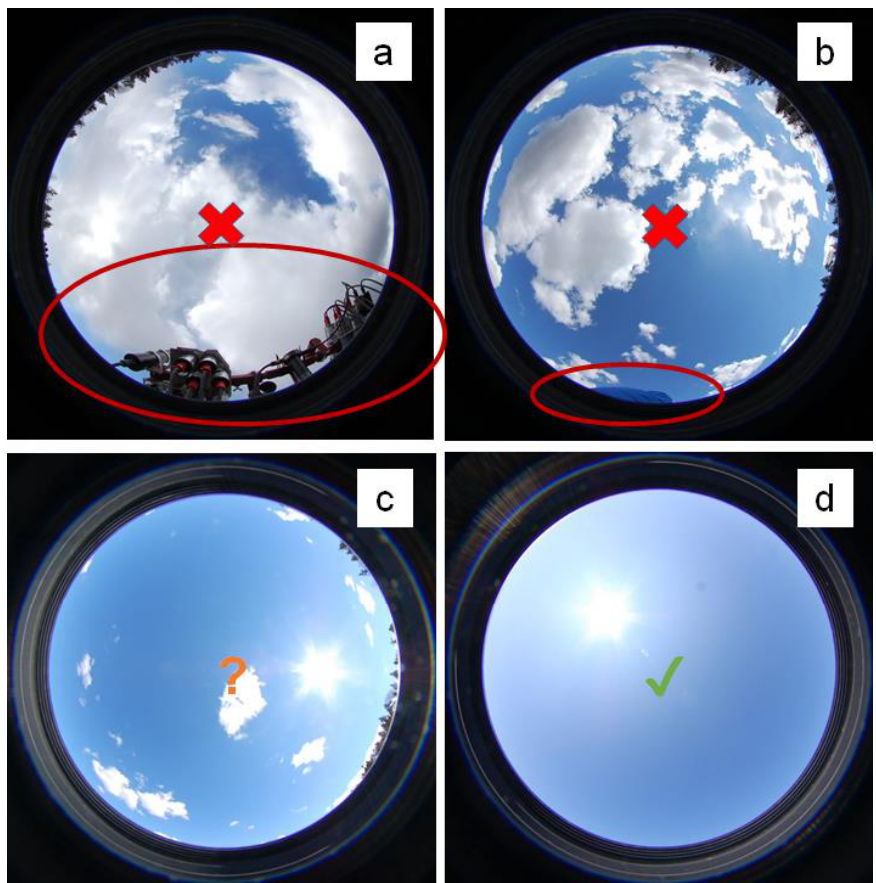
Figure 5. Example fish-eye photos taken to check for contamination of 𝐸 𝑑0+ measurements. ( a ) Contamination of field of view by other radiometers; ( b ) Contamination of field of view by a scientist in the bottom of the photo; ( c ) No contamination of field of view, partly cloudy sky; ( d ) No contamination of field of view, clear sky. The trees visible in the bottom-left photo, typical of inland water or very nearshore measurements, do affect the measurement, but are not considered as “contamination” in the context of this review. The impact of such far -field objects contributes to the natural downwelling irradiance at the measurement location, and should be measured as such.